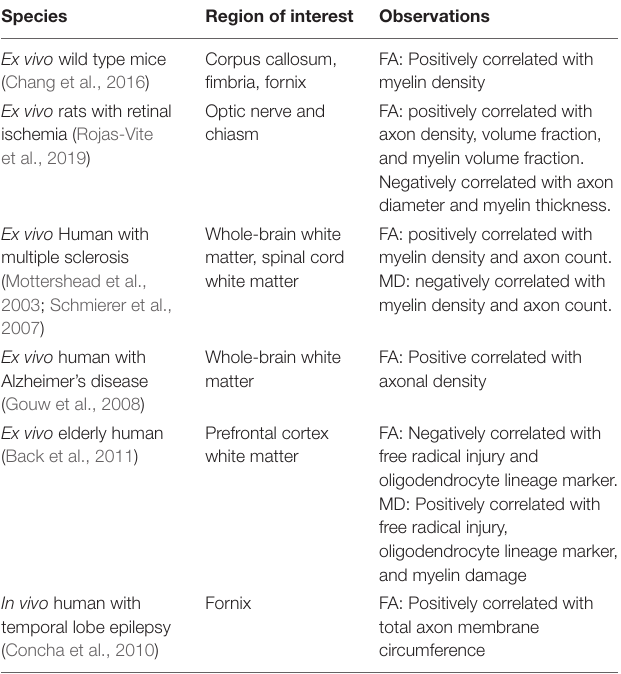
TABLE 1 | Analysis of studies correlating tensor metrics with cellular properties.